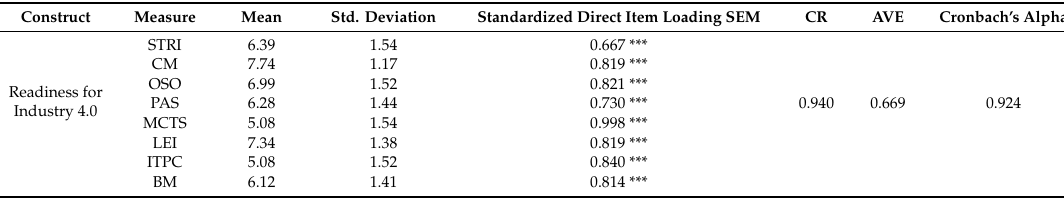
Table 2. Confirmatory factor analysis with descriptive statistics for the Industry 4.0 readiness model in SEM. Construct Measure Mean Std. Deviation Standardized Direct Item Loading SEM CR AVE Cronbach’s Alpha